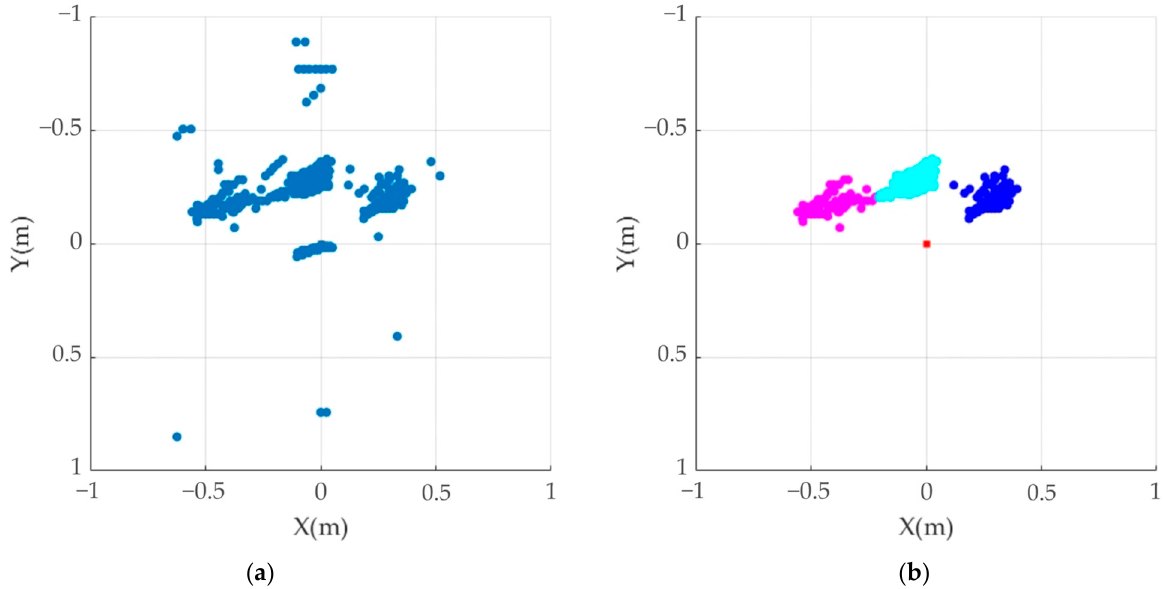
Figure 13. This image depicts the top view of a point cloud in a static use case involving three people leaning right in the back row. The original point cloud image is on the left ( a ), whereas the right figure ( b ) shows the result of the clustering and post-processing steps. Different colors are used to represent different categories of point clouds, with the positive Y-axis pointing towards the front.